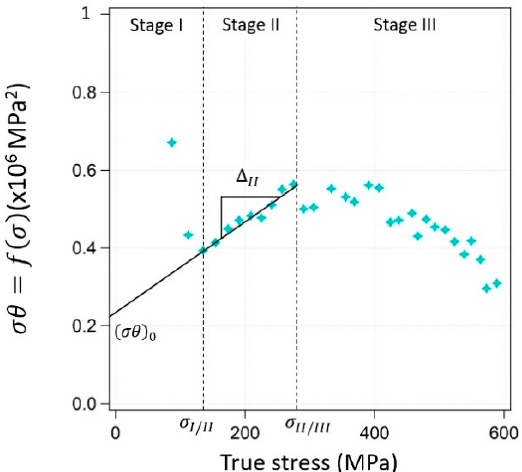
Figure 4. Example of the evolution of the σ · θ product with stress for polycrystalline Ni (d = 25 µ m),